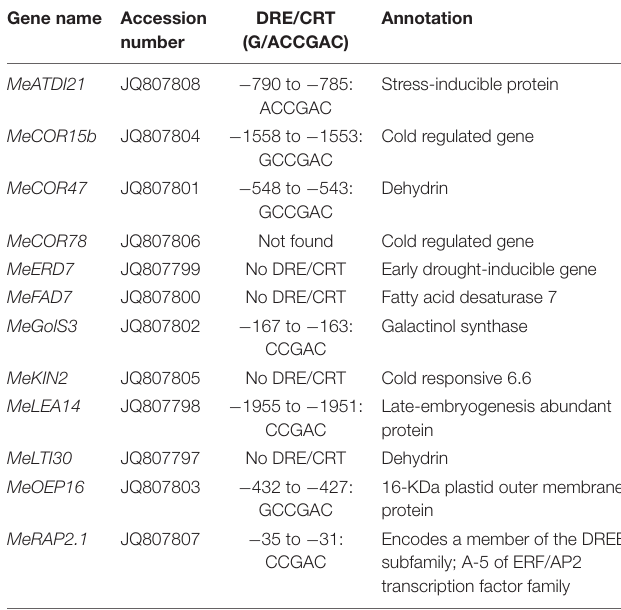
TABLE 1 | CBF3-targeted orthologous genes in